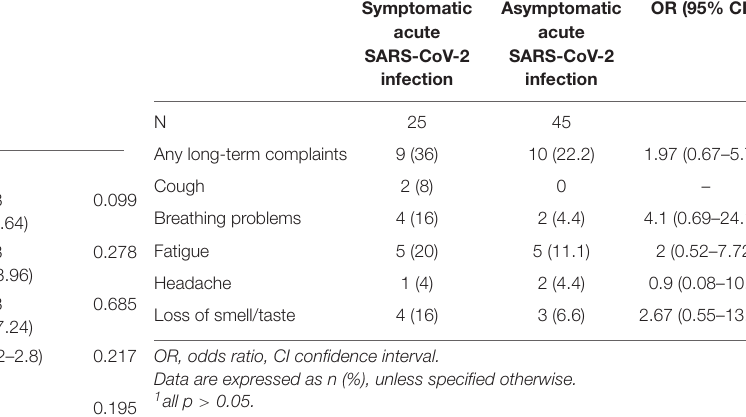
TABLE 4 | Characteristics of participants with and without abnormal 1 pulmonary function.